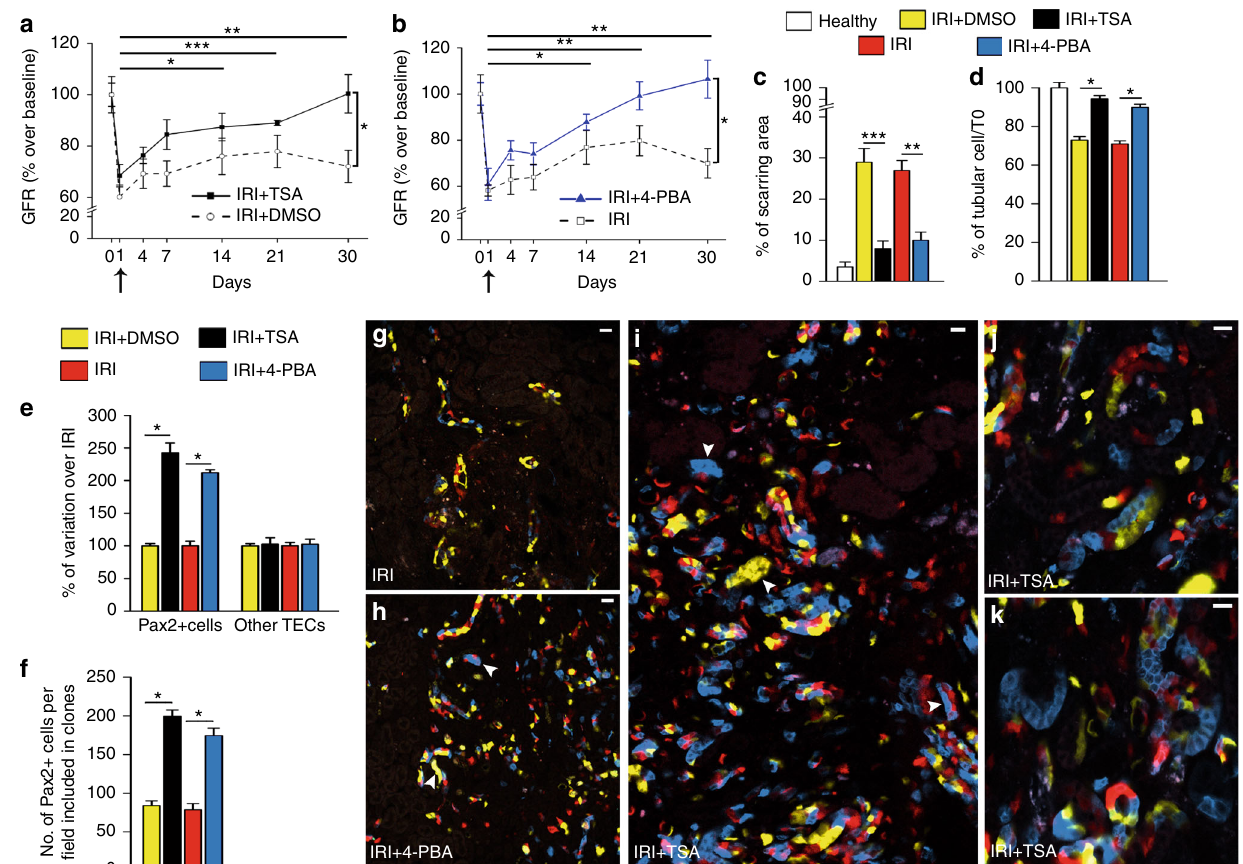
Fig. 5 Drugs that promote tubular regeneration after AKI selectively enhance Pax2 lineage-positive cell mitosis. a , b GFR after IRI ( n = 6), IRI + DMSO ( n = 7), TSA ( n = 7) or 4-PBA treatment ( n = 6). One-way ANOVA post hoc Tukey. Arrows indicate starting of treatment. c Percentage of kidney area with tubular injury in kidney sections of Pax2/Confetti mice at day 0 (healthy, n = 4), at day 30 after IRI + DMSO ( n = 4) or IRI ( n = 6) and at day 30 after IRI + TSA ( n = 4) or 4-PBA ( n = 6) treatment ( n = 4 images per mouse). Mann – Whitney test. *** p < 0.001 IRI + TSA vs. IRI + DMSO, ** p < 0.01 IRI vs. IRI + 4-PBA. d Percentage of TECs in Pax2/Confetti mice in healthy ( n = 4), at day 30 after IRI + DMSO ( n = 4) or IRI ( n = 5) and at day 30 after IRI + TSA or 4-PBA treatment ( n = 4 per each group) vs. T0. Mann – Whitney test. * p < 0.05 IRI + TSA vs. IRI + DMSO and IRI vs. IRI + 4-PBA. e Percentage of variation of Pax2 + and Pax2 − TECs in Pax2/Confetti mice at day 30 after IRI + TSA or 4-PBA treatment ( n = 4 per each group) vs. IRI + DMSO ( n = 4) or IRI ( n = 5). Mann – Whitney test. * p < 0.05 IRI + TSA vs. IRI + DMSO and IRI vs. IRI + 4-PBA. f Number of cells included in clones in Pax2/Confetti mice at day 30 after IRI + DMSO ( n = 4) or IRI ( n = 5) and at day 30 after IRI + TSA or 4-PBA treatment ( n = 4). Mann – Whitney test. * p < 0.05 IRI + TSA vs. IRI + DMSO and IRI vs. IRI + 4-PBA. g – k Clones in Pax2/Confetti mice at day 30 after IRI ( n = 4) ( g ), and after IRI + 4-PBA treatment ( n = 4) ( h ) or + TSA treatment ( n = 4) ( i – k ). Arrows indicate clones. Data are mean ± SEM. Scale bars 20 µ m. Pax2 + = Pax2 lineage-positive